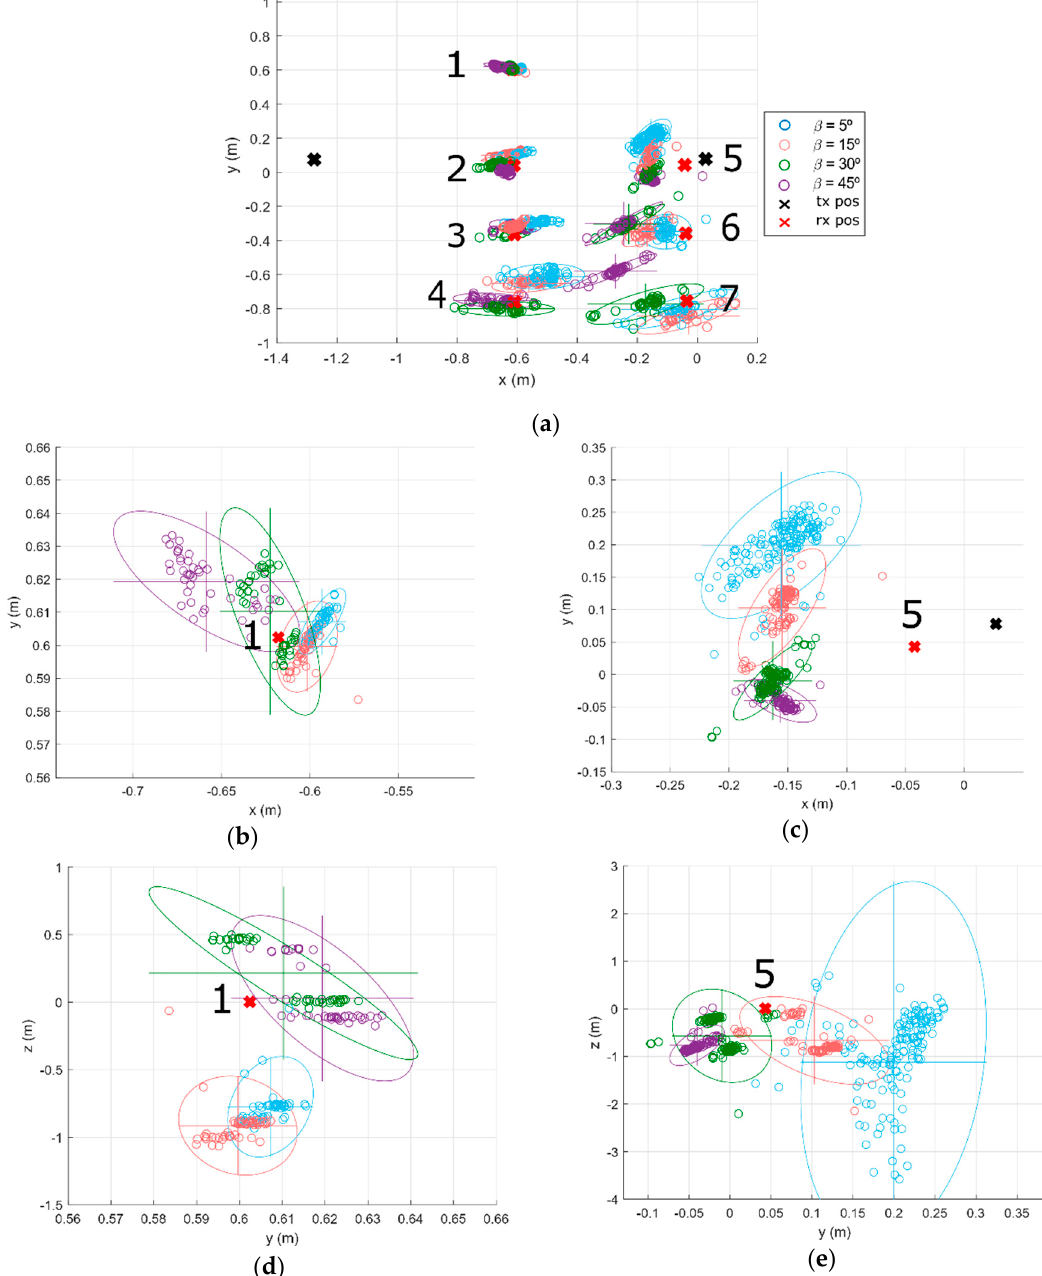
Figure 11. Estimated positions and ground-truth in points P1 to P7 after 100 trials: ( a ) general view; ( b ) zoom in point P1 of the XY plane; ( c ) zoom in point P5 of the XY plane; ( d ) zoom in point P1 of the YZ plane; ( e ) zoom in point P5 of the YZ plane.